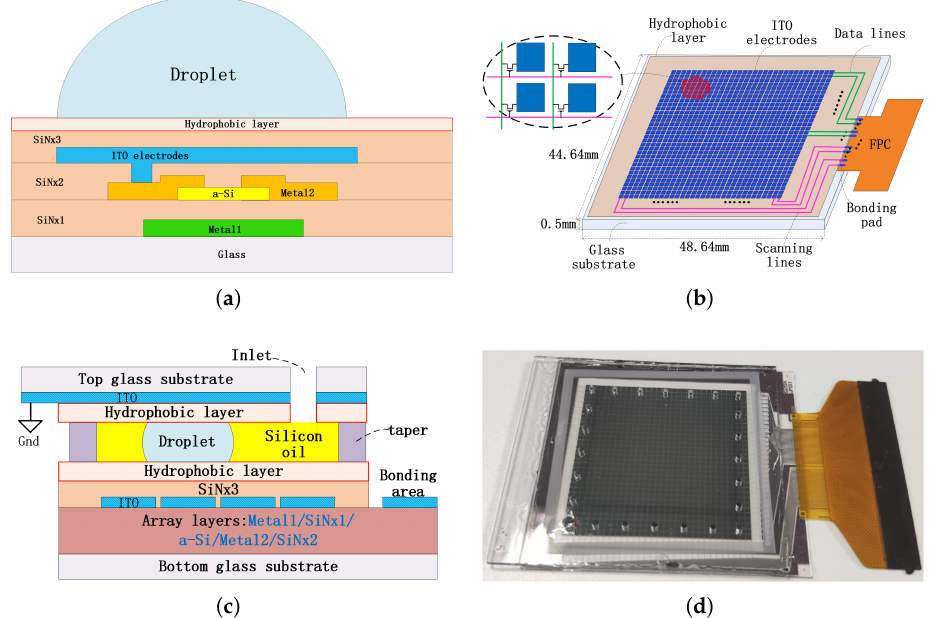
Figure 2. ( a ) Schematic of the cross section of single-planar TFT backplane, which contains the TFT structure and topmost ITO droplet driving electrode; ( b ) Schematic of the single-planar AM- EWOD TFT device; ( c ) Schematic of the cross section of sandwiched structure AM-EWOD device; ( d ) Photographs of AM-EWOD device with top ITO